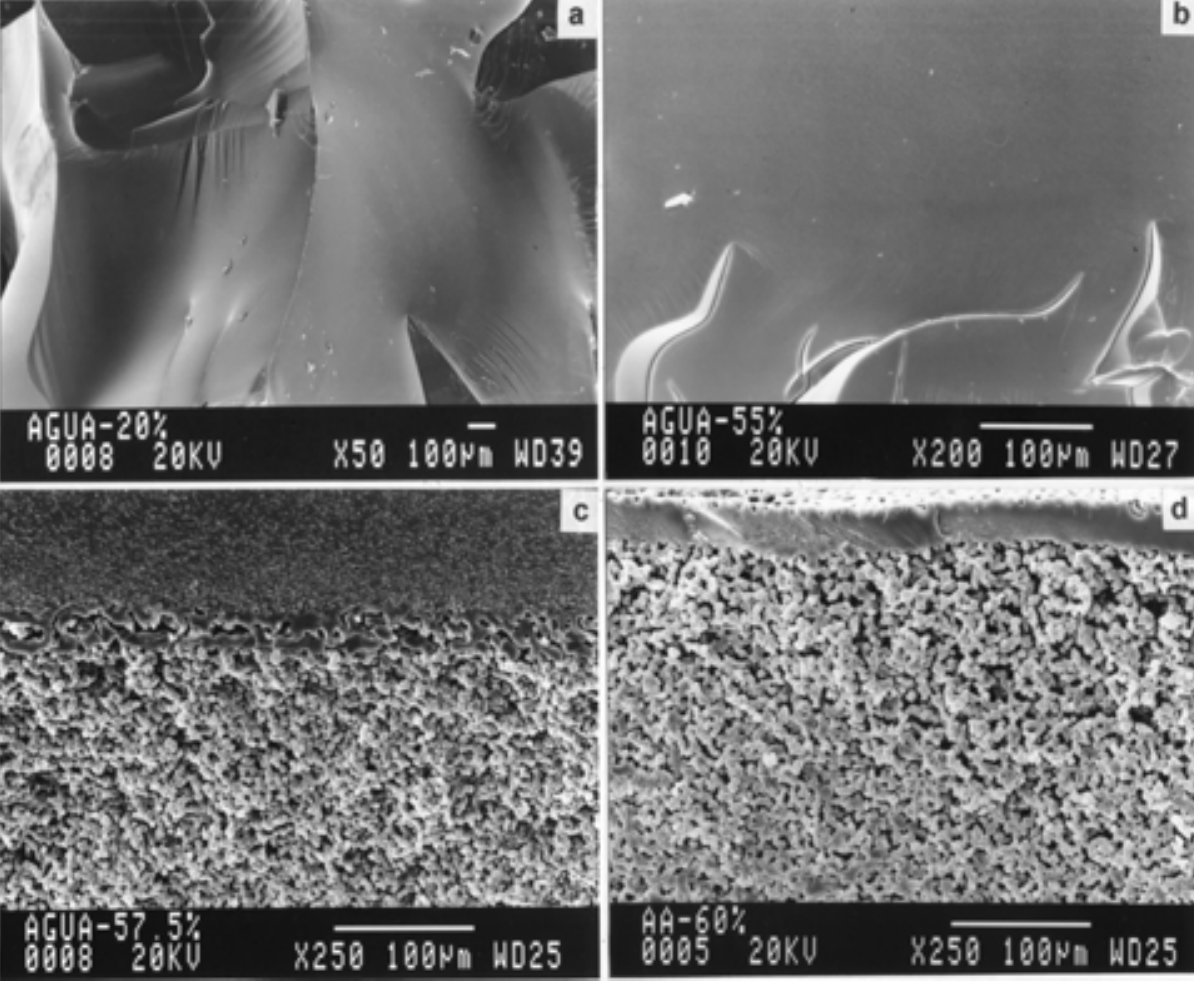
Figure 3. Photomicrography of polyHEMA porous sponge fractures in case of water concentration used in solution polymerization (a) 20%; (b) 55%; (c) 57.5% and (d)